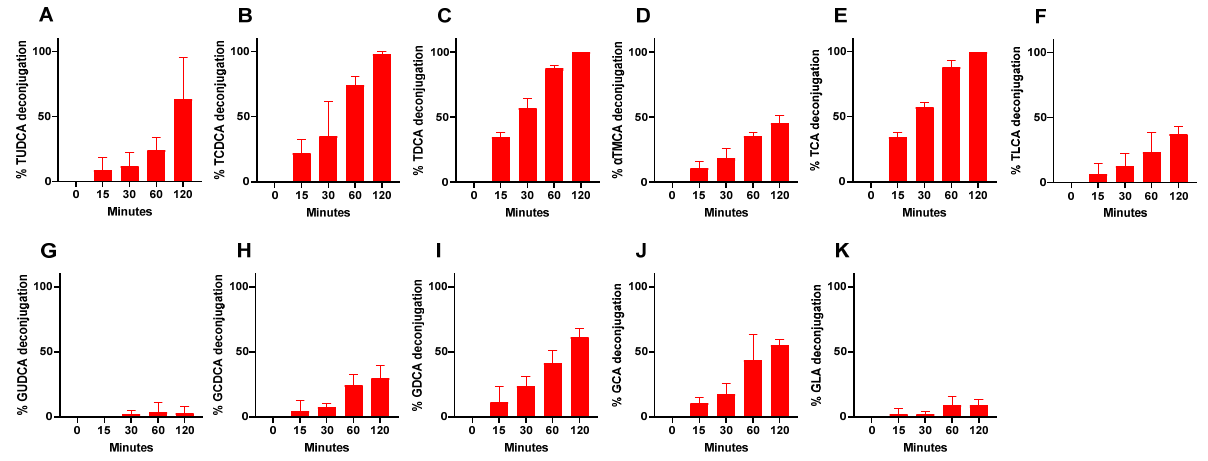
Figure 5. Bile acids deconjugation activity of CNCM I-4884 supernatant ( A – K ). TUDCA, taurour- sodeoxycholic acid; TCDCA, taurochenodeoxycholic acid; TDCA, taurodeoxycholic acid; TCA, tau- rocholic acid; TLCA, taurolitocholic acid; α TMCA, α -tauromuricholic acid; GUDCA, glycoursode- oxycholic acid; GCDCA, glycochenodeoxycholic acid; GDCA, glycodeoxycholic acid; GCA, gly- cocholic acid; GLC, glycolitocholic acid. Values are expressed as percentage ± SEM (standard error of the mean). Data are the means of three independent replicates.